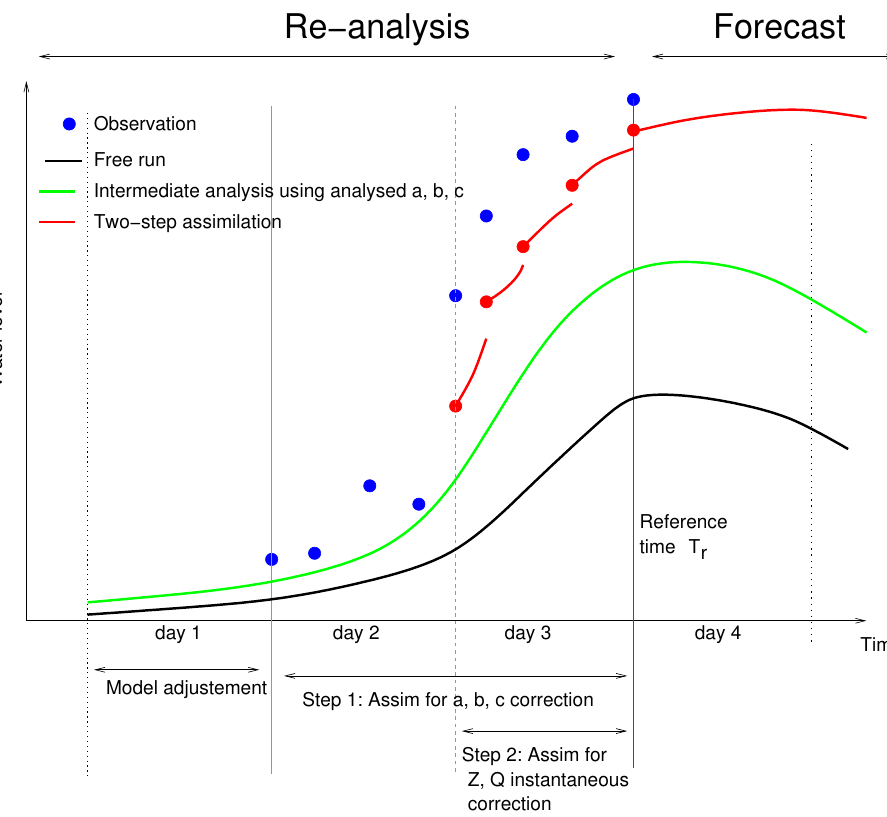
Fig. 3. Schematic representation of the two-step assimilation algorithm over one